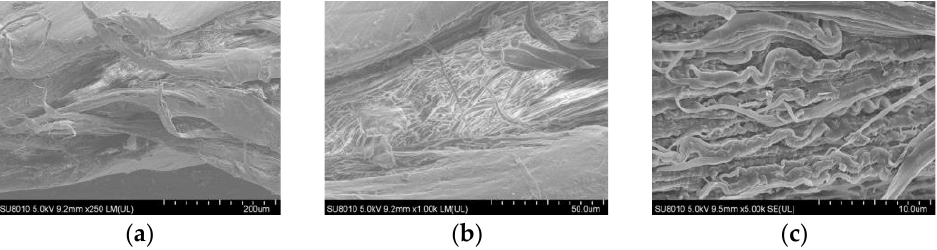
Figure 7. Microstructure of fracture surface of the HDPE specimens. ( a ) SEM image of 250 times; ( b ) SEM image of 1000 times; ( c ) SEM image of 5000 times.